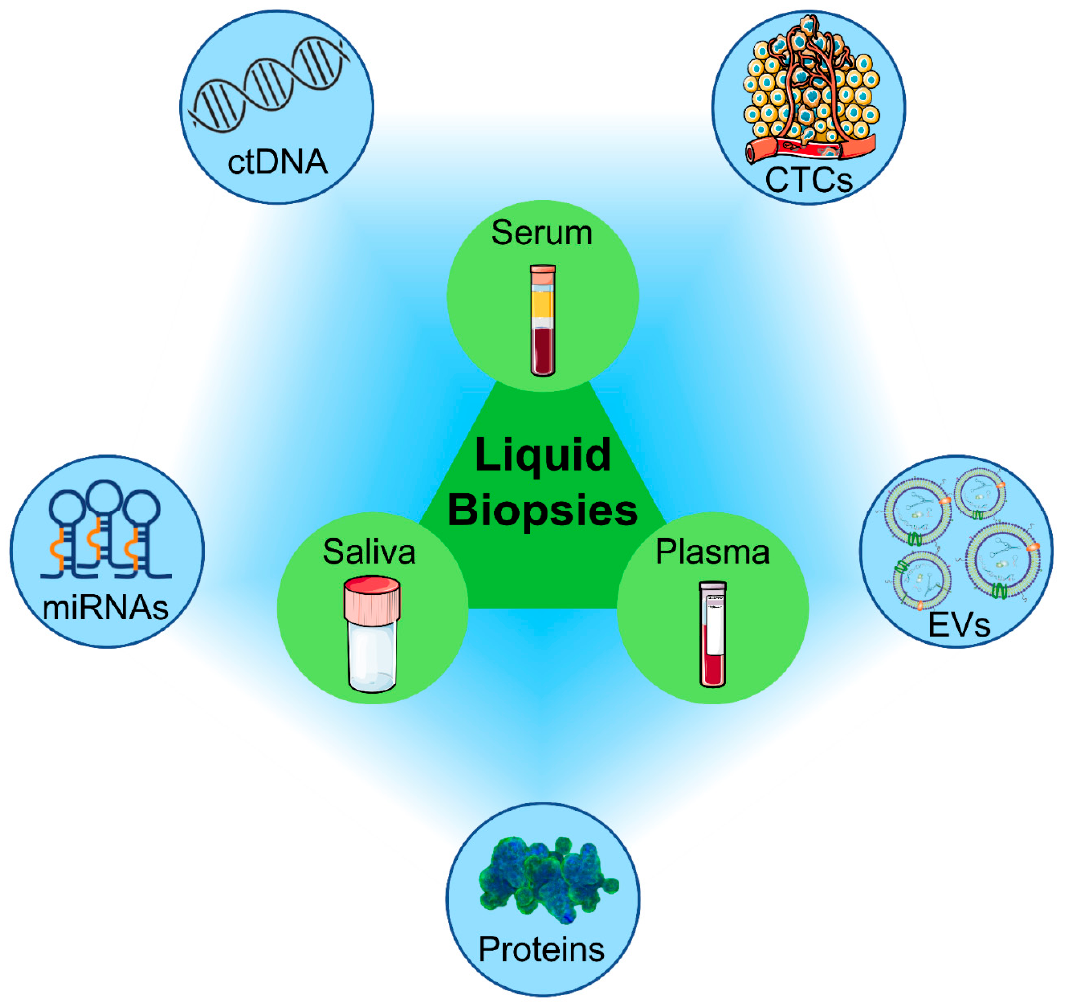
Figure 1. Liquid biopsy-based biomarkers. Abbreviations: CTCs—circulating tumor cells; ctDNA— circulating tumor DNA; miRNAs—microRNA; EVs—extracellular vesicles.